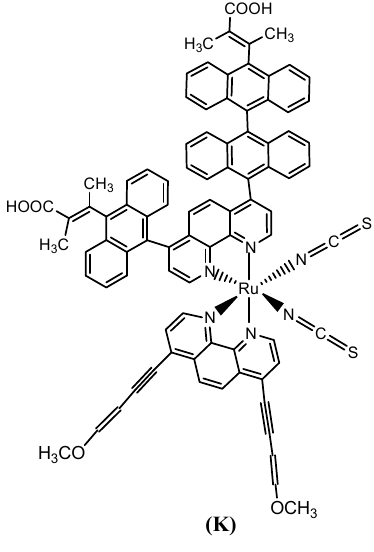
Figure 11. Molecular structure of Ru(II) phenanthroline ligand with alkynyl and anthracenyl